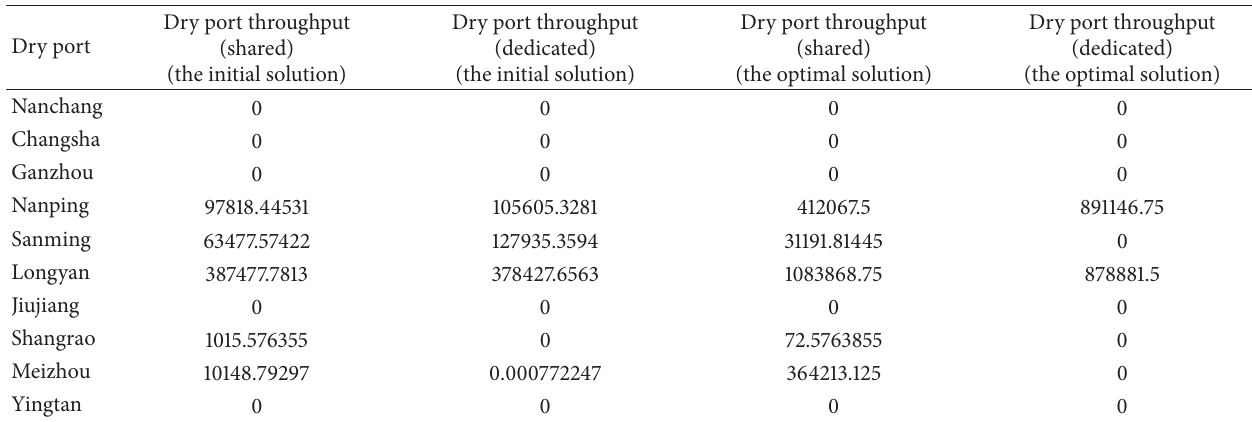
Table 8: Initial solution and optimization result after 200